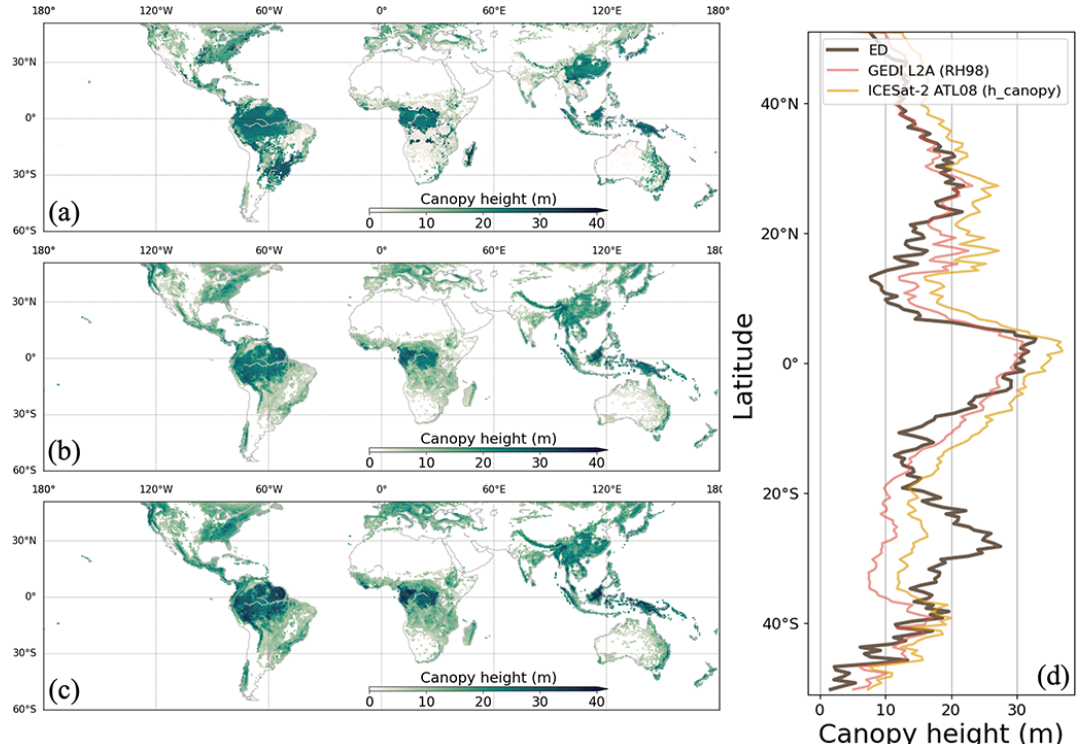
Figure 17. Canopy height from ED (a) , GEDI L2A (b) and ICESat-2 ATL08 (c) . Latitudinal averages are compared in (d) . ESA CCI data grids with tree fractions below 5% are